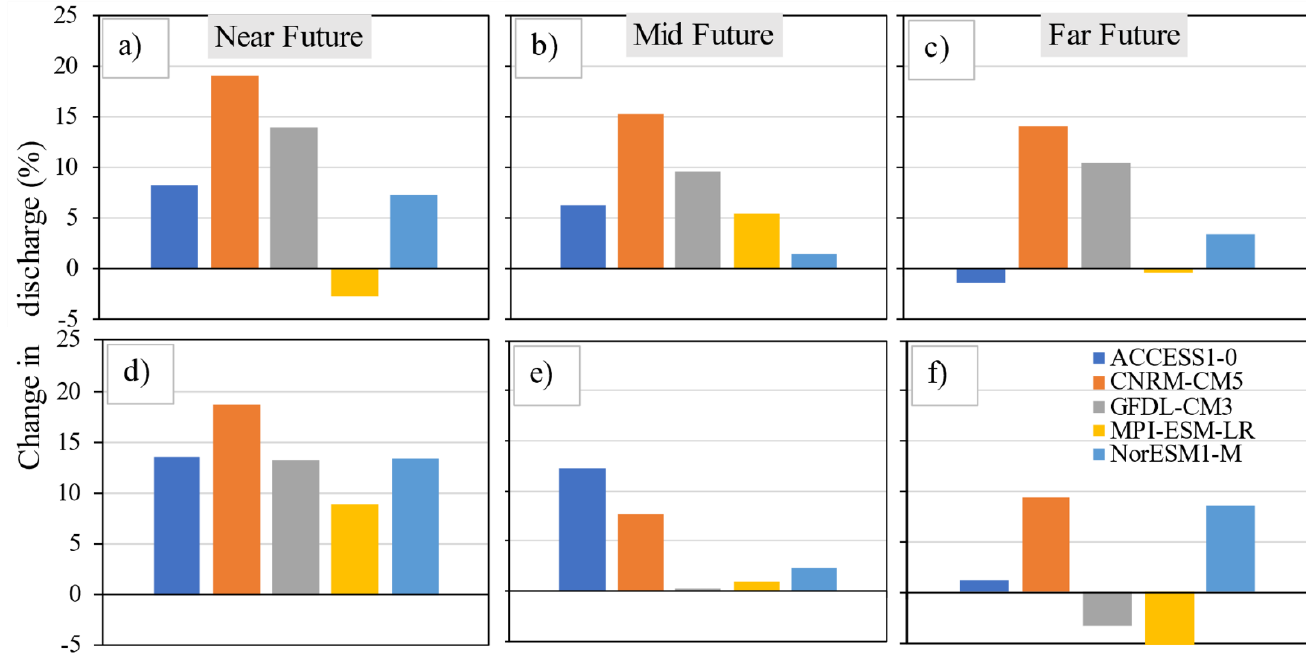
Figure 10. Changes in the streamflow (discharge) measured at Rimma gauge station for three future time windows, namely, Near Future (2021–2040), Mid Future (2041–2070), and Far Future (2071–2100) using multiple climate models under RCP 4.5 ( a – c ) and RCP 8.5 ( d – f ). ( a – c ) show the percentage change in streamflow under the RCP 4.5 emission scenario. ( d – f ) show the same under the RCP 8.5 emission scenario. Additionally, ( a , d ) show the same for the Near Future, ( b , e ) for the Mid Future, and ( c , f ) for the Far Future.